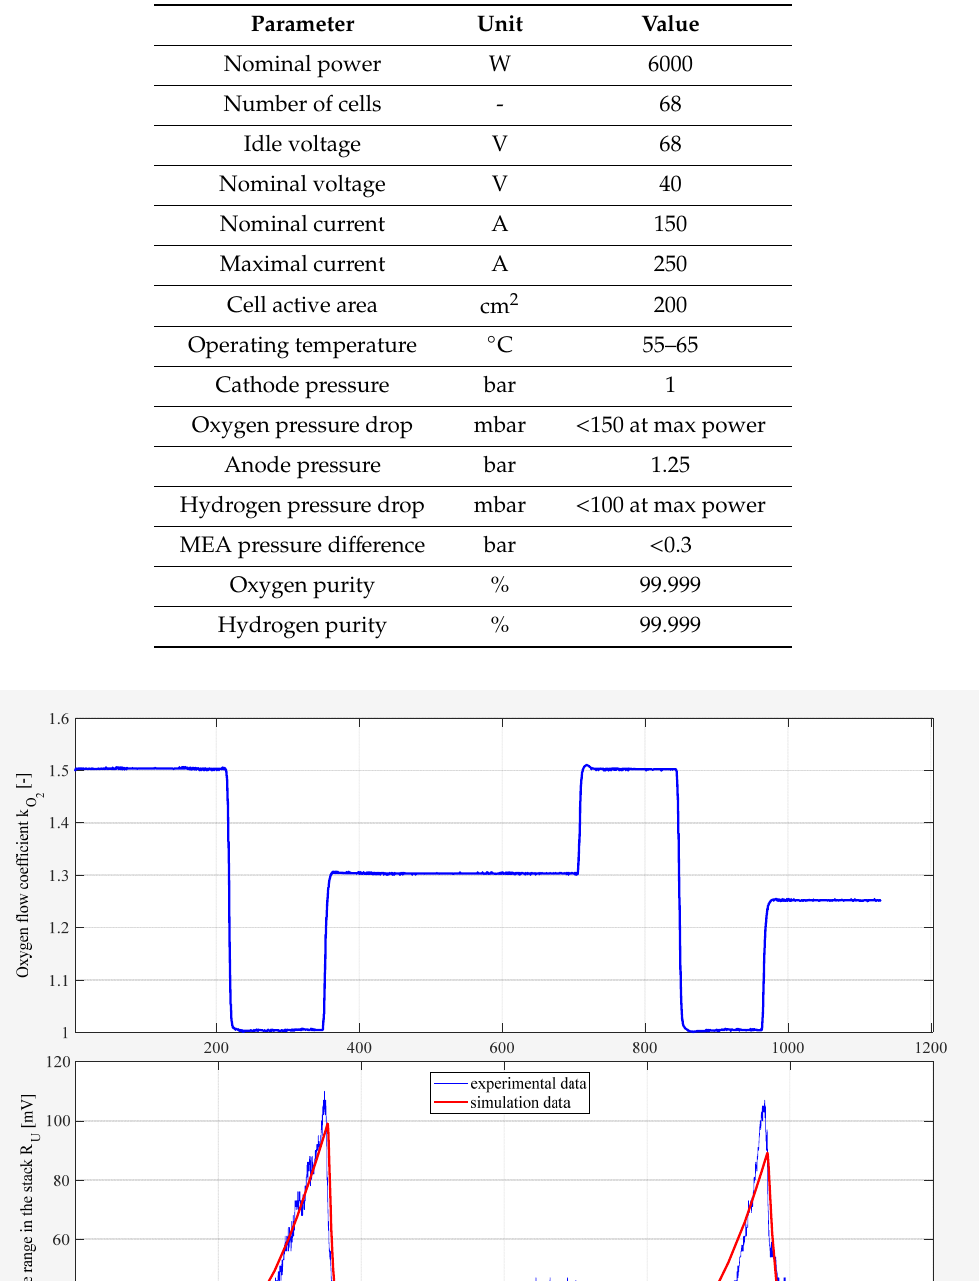
Table 3. Parameters of the fuel cell system used for identification of voltage range model.